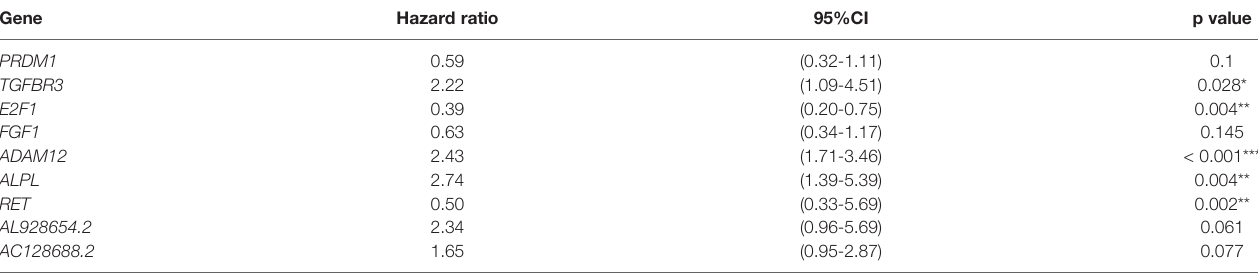
TABLE 1 | Cox proportional hazards regression model including the key members of the ceRNA network for overall survival in patients with thyroid carcinoma. Gene Hazard ratio